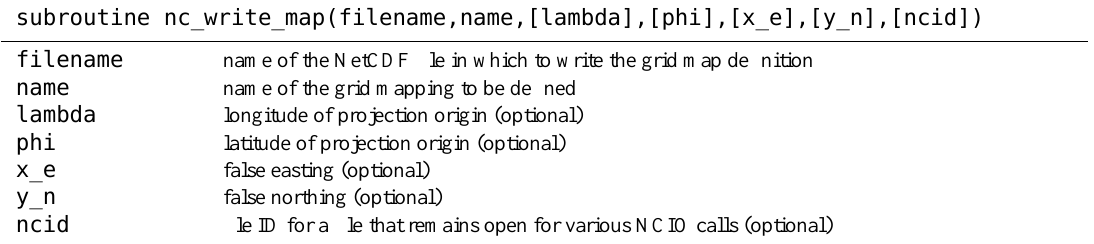
Table A6. Subroutine call and argument descriptions for nc_write_map .